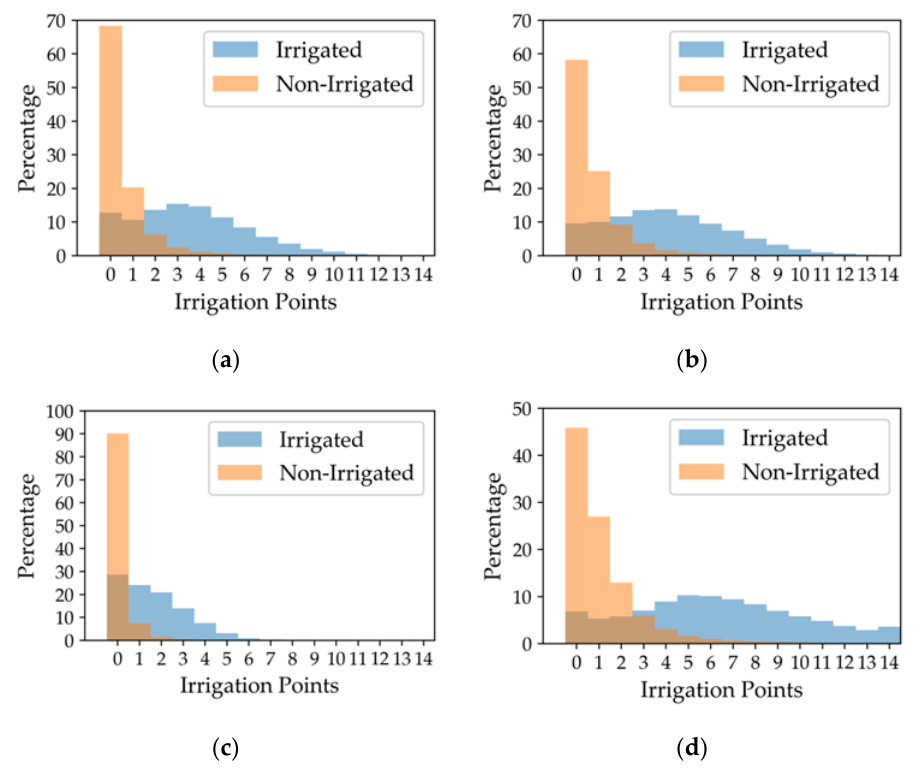
Figure 8. Distribution of the irrigation points detected over irrigated (blue) and non-irrigated (orange) plots in Catalonia Spain for ( a ) morning SAR acquisition, ( b ) evening SAR acquisition, ( c ) intersection between morning and evening acquisitions and ( d ) combination between morning and evening acquisitions.